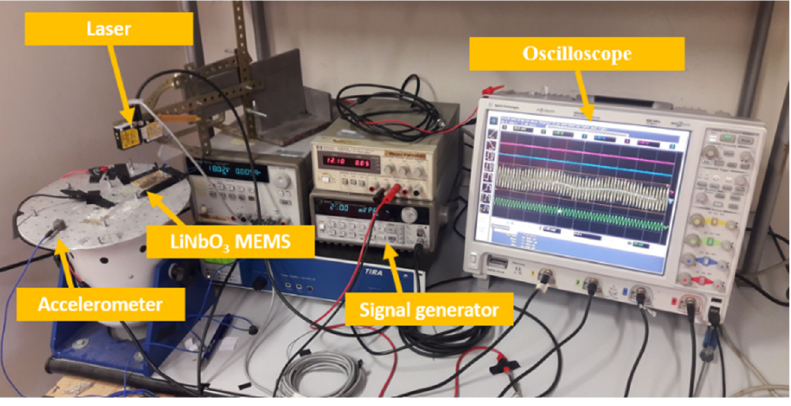
Figure 7. Experimental Setup.